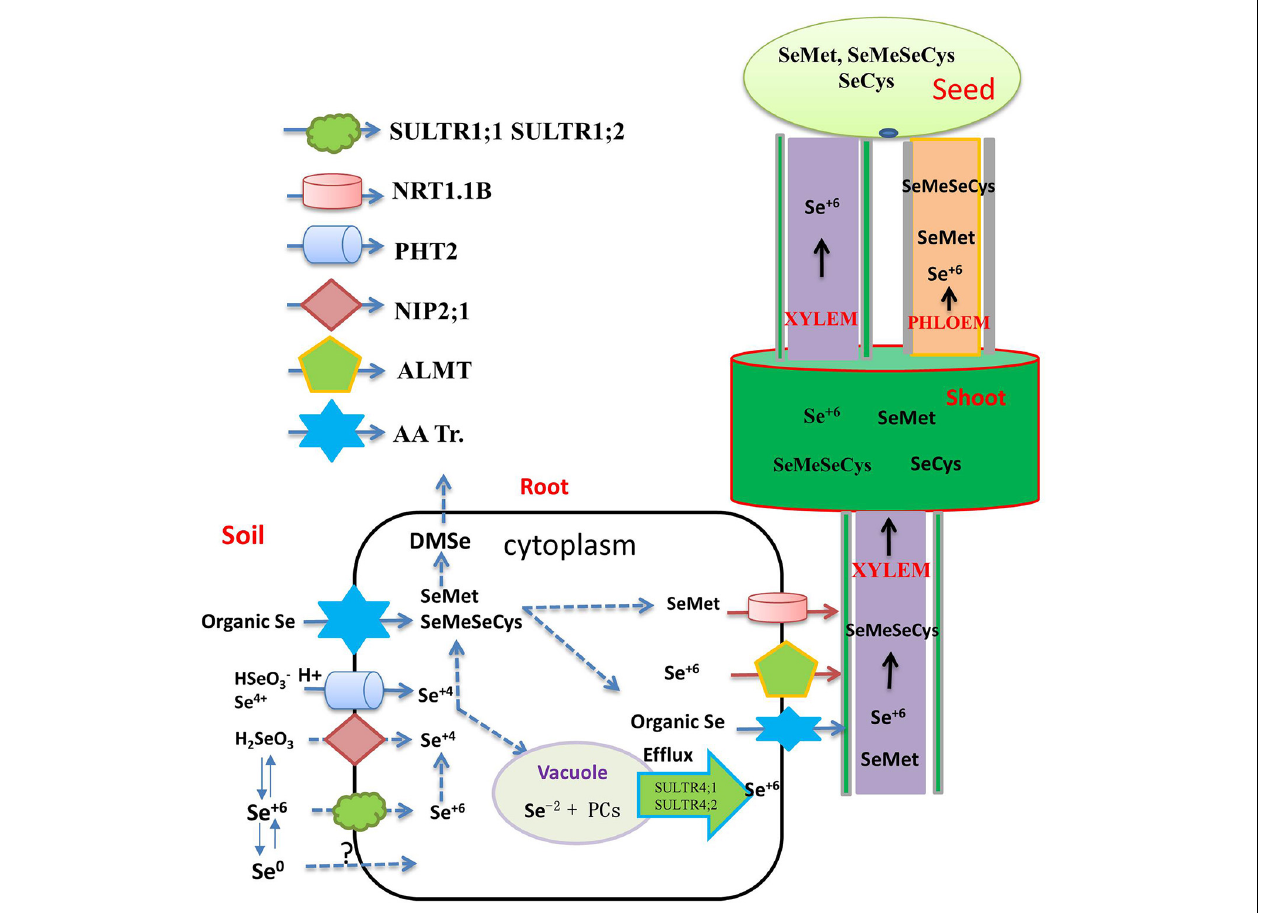
FIGURE 1 | Flow diagram representing the transporters involved in the uptake, translocation, and accumulation of different selenium species through xylem and phloem to the grain. The main transporters involved in inorganic Se uptake by plants (SULTR1;1, SULTR1;2 for selenate, NIP2;1, PT2 and PT8 for selenite, AA Tr. For amino acids). Organic Se forms are transported into the xylem via amino acid permeases (AA Tr.) and delivered to the shoots. Selenate is the major Se species present in the xylem and loaded into the xylem by SULTR2;1. Organic-Se compounds are transported into the seed via the phloem, while selenate is transported via both xylem and phloem. The translocation of SeMet to the seeds is enhanced by overexpression of the NRT1;1B transporter.